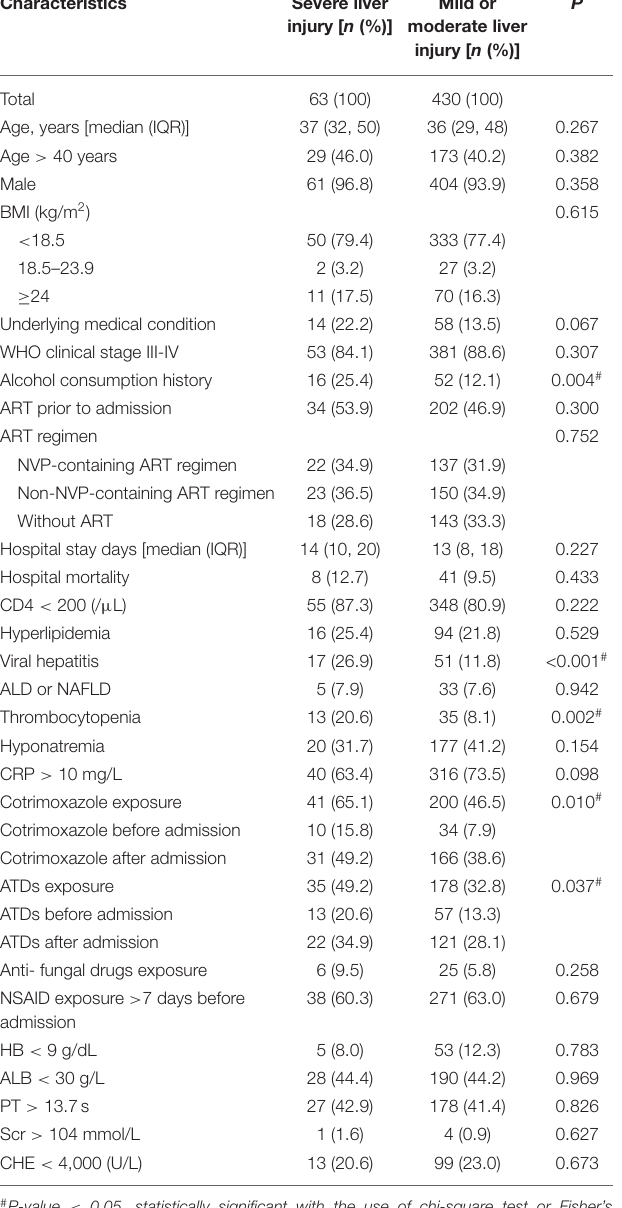
TABLE 3 | Factors associated with severe liver injury among HIV-infected TABLE 2 | Baseline characteristics of patients with severe liver injury compared inpatients in Shenyang. with mild or moderate-liver injury patients. Characteristics Severe liver Factors OR (95%CI) P1 Adjust OR (95%CI) injury [ n (%)]